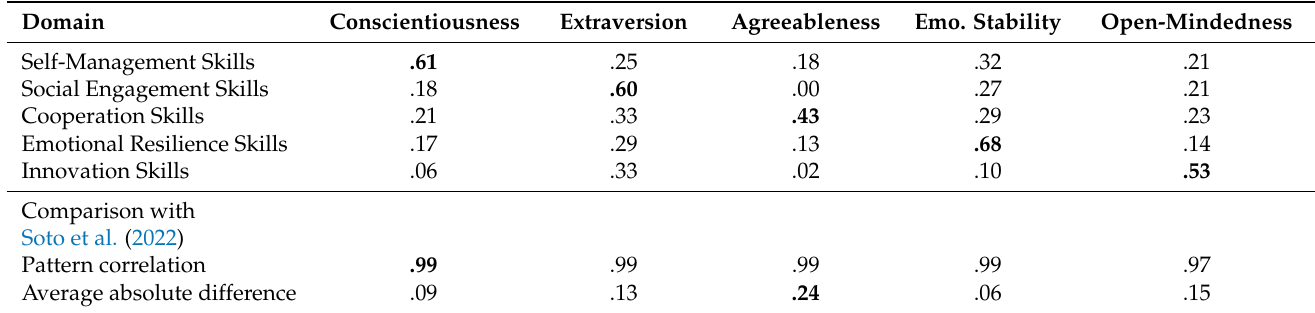
Table 7. Correlations of the BESSI-G domains with the Big Five domains (Study 3).